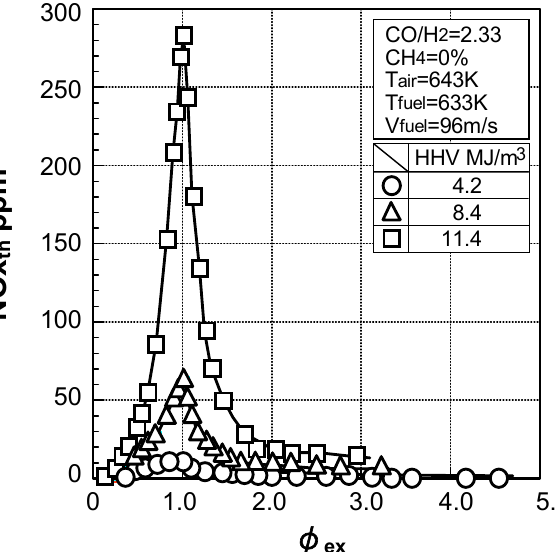
Figure 23. Influence of fuel calorific value on relation between equivalence ratio and thermal-NOx